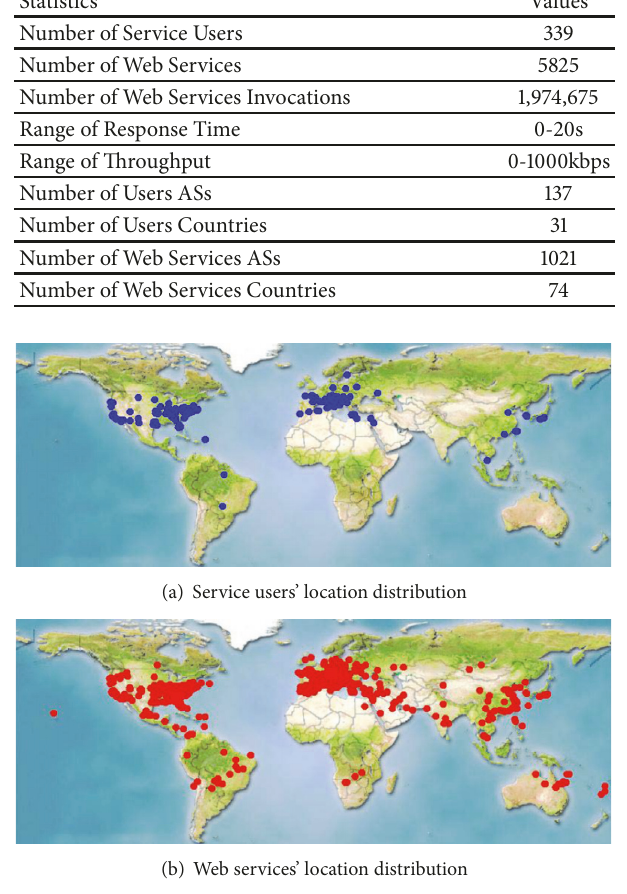
Figure 6: Location distribution: (a) service users’ location distri- bution, with 339 service users distributed in 31 countries; (b) Web services’ location distribution, with 5825 Web services distributed in 74 countries. There are 1,974,675 invocation records between the users in (a) and the services in